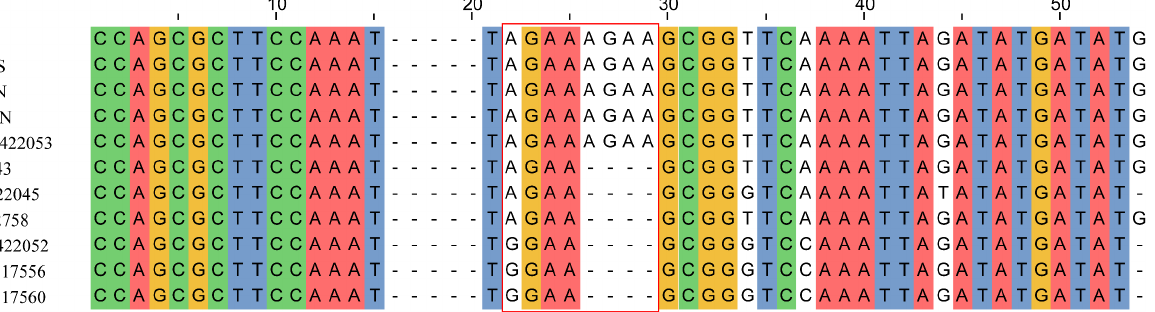
Figure 2. The partial sites in the trnL-trnF spacer region of some sequences. The red box means “AGAA”-SSR in N. petersiana .